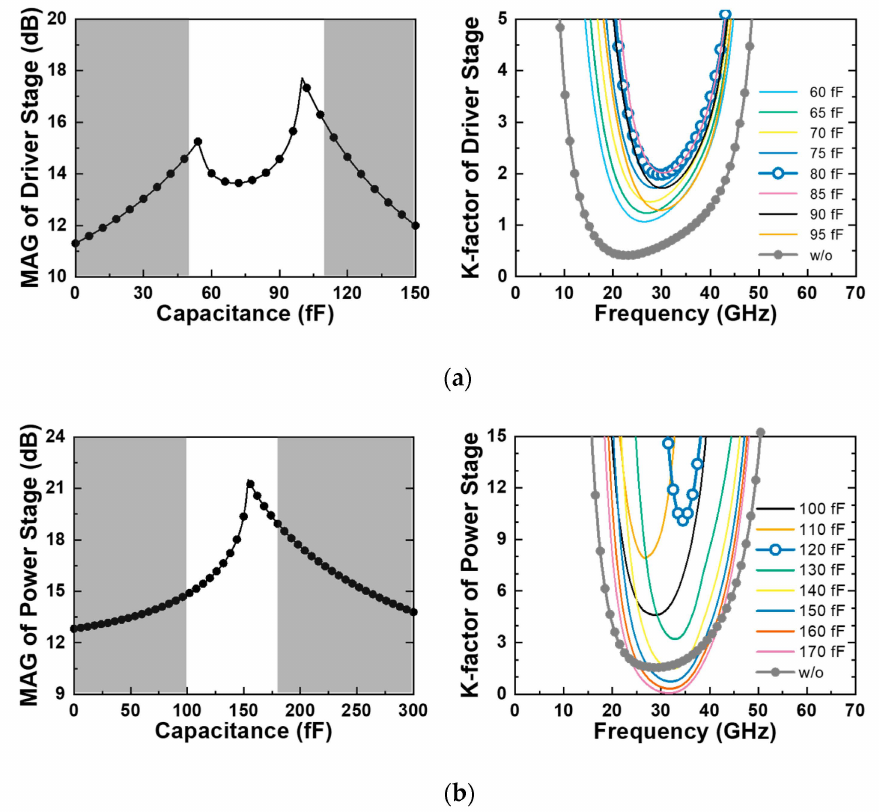
Figure 4. Simulated MAG and K-factor according to the neutralization capacitor: ( a ) driver and ( b ) power